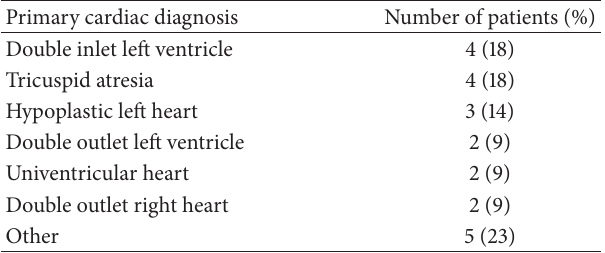
Table 2: Patient demographics.